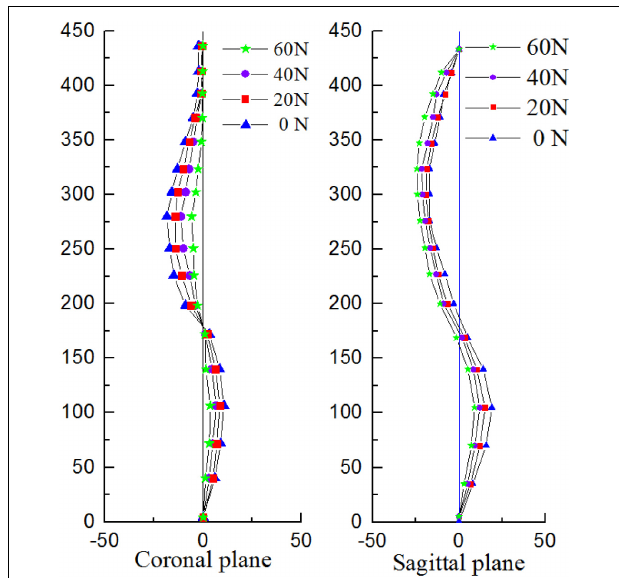
FIGURE 9 | Changes in the curvature of the spine with different correction forces.